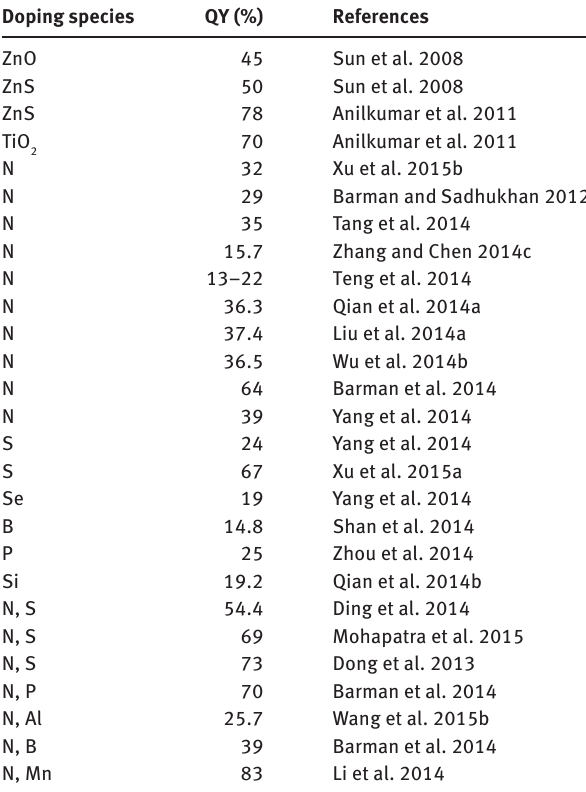
Table 2: Quantum yield of doped CDs with several species and following different strategies.